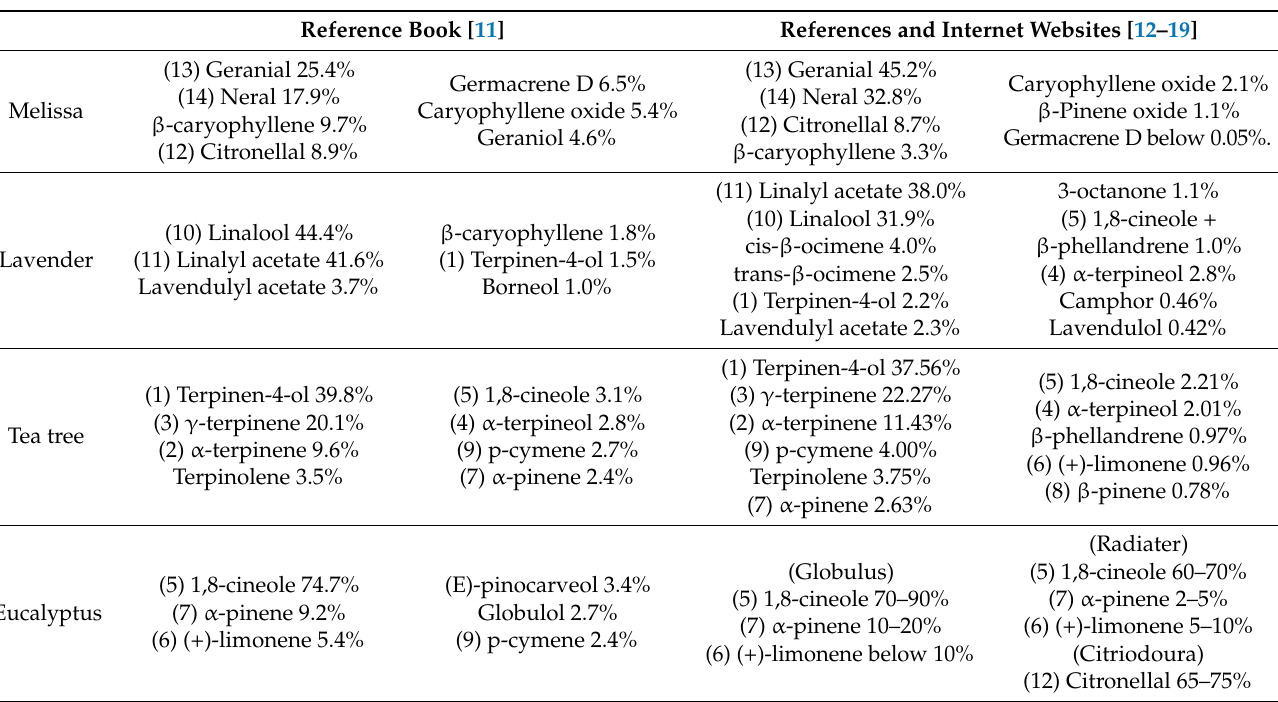
Table 1. The concentration of major components in four essential oils researched from the book, references including internet